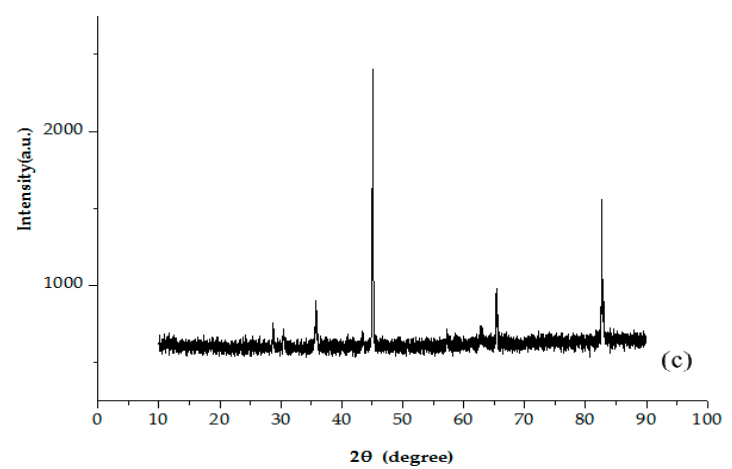
Figure 3. EDS spectrum of the carbon steel ball surface before ( a ) and after ( b ) oxidation; ( c ) XRD pattern of the oxidation nanosheet. Red boxes represent diffraction peaks of Fe 3 O 4 .